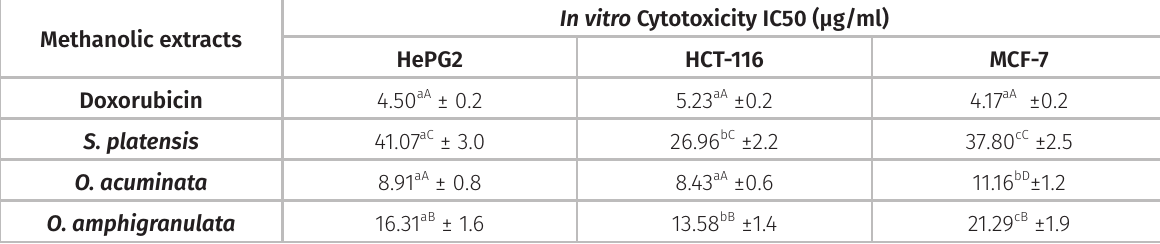
Table V. Cytotoxicity (IC ) of the tested cyanobacterial methanolic extracts on different cell lines*. 50 Methanolic